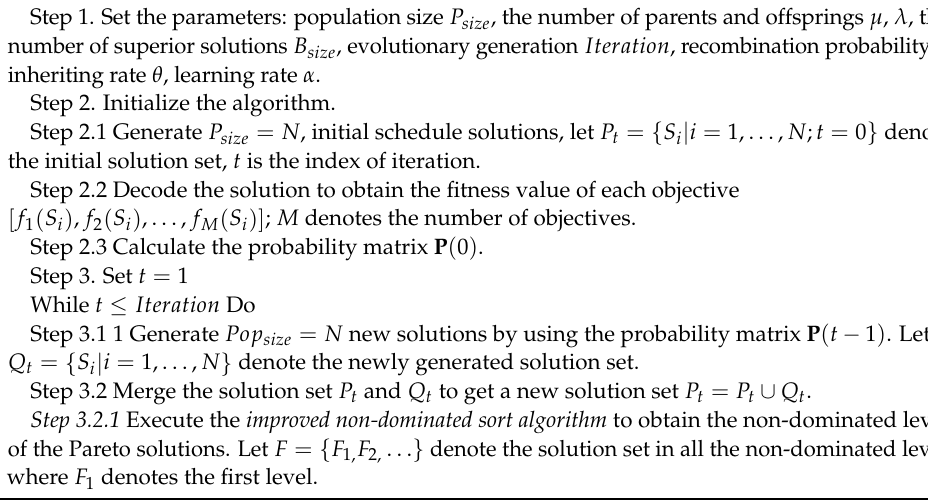
Algorithm 1. The pseudocode of MO-HEDA.